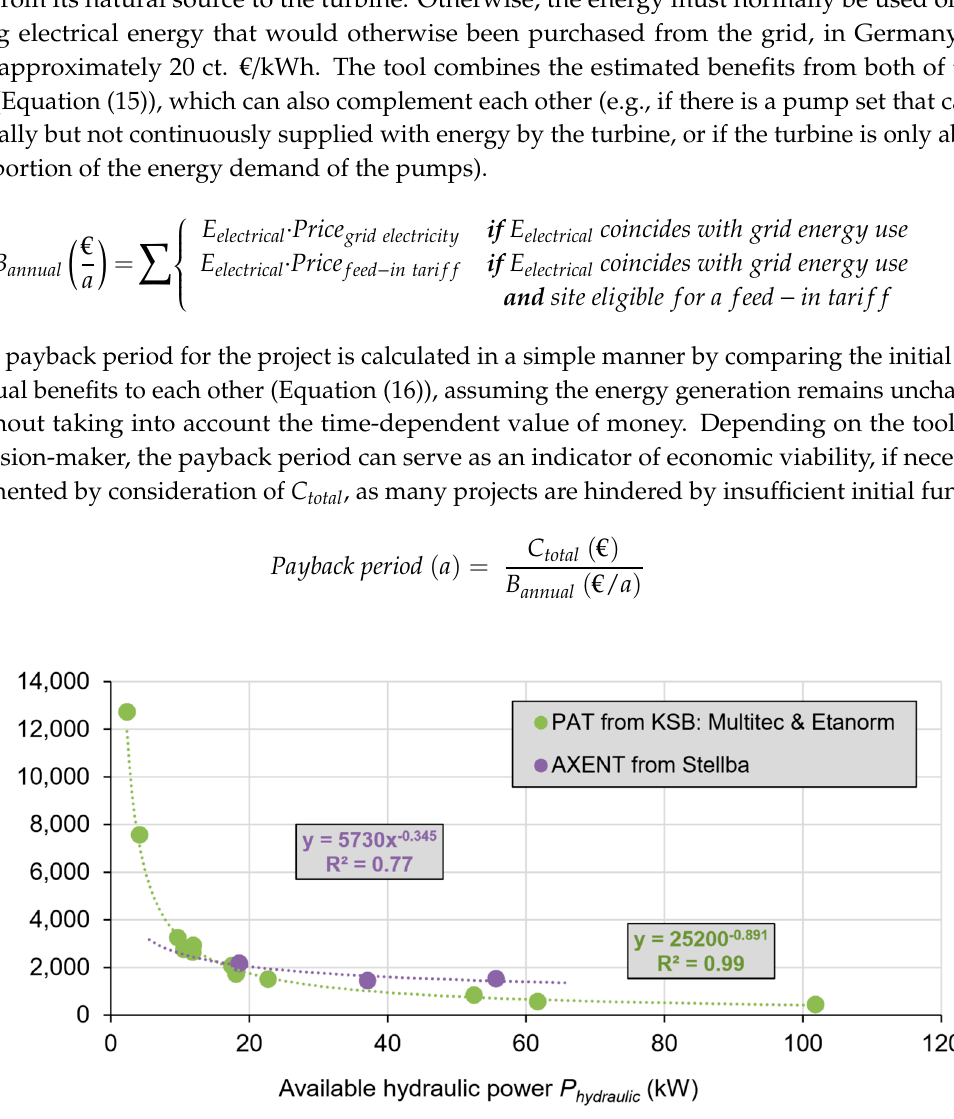
Figure 4. Specific project costs for AXENT and PATs, with best-fit power law curves.